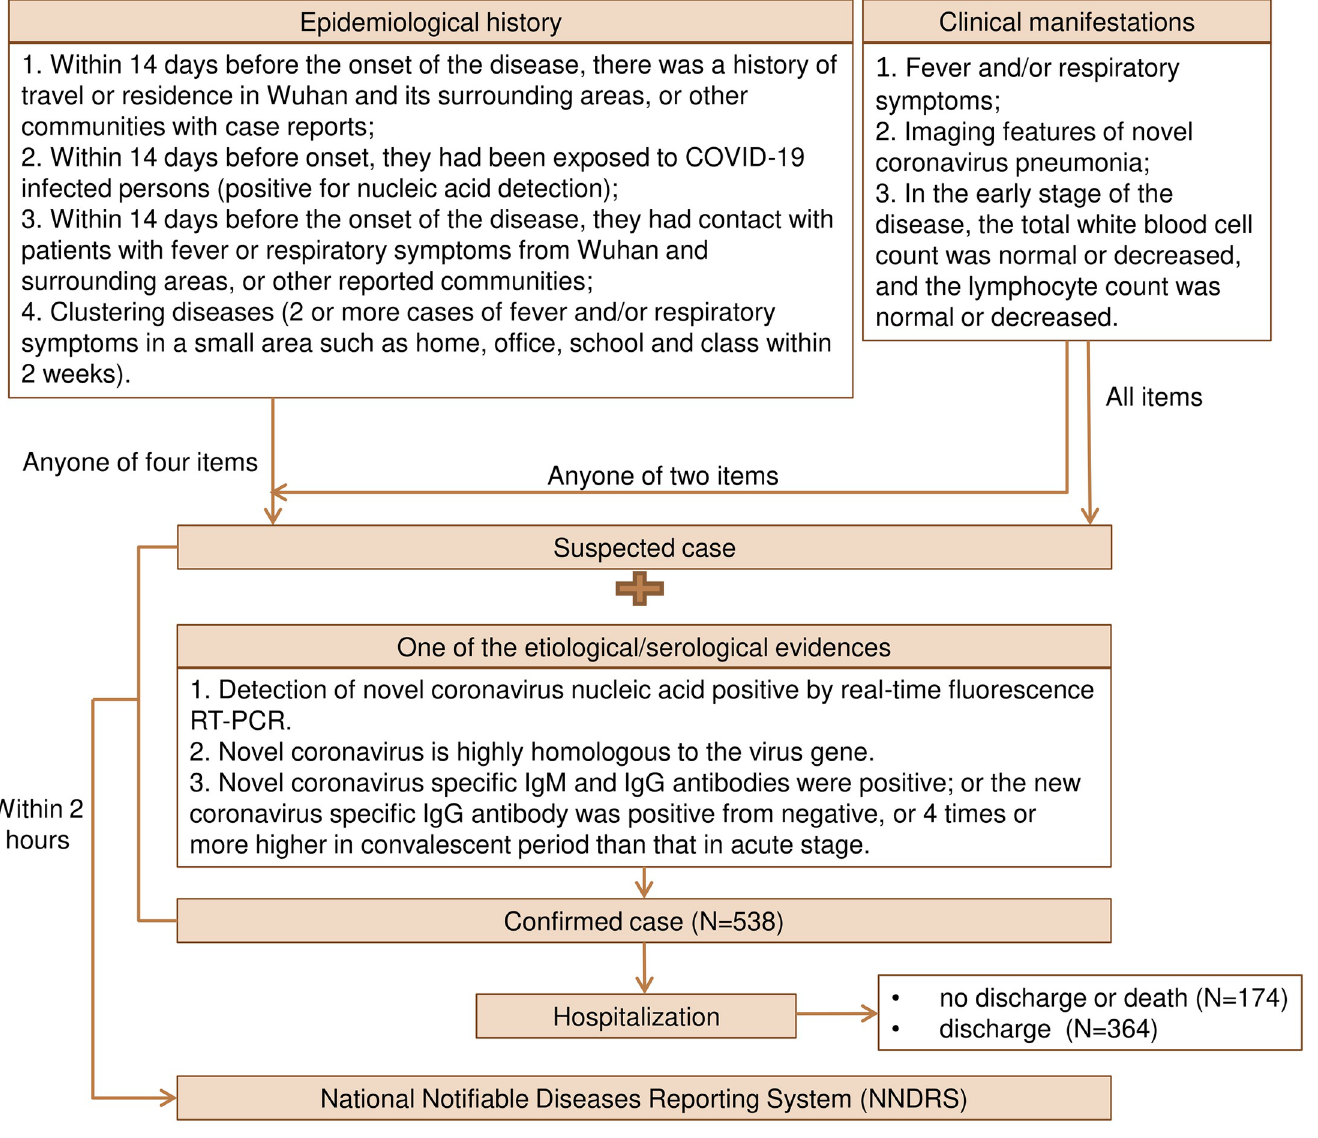
Fig 1. Flow diagram of diagnostic protocol for novel coronavirus pneumonia